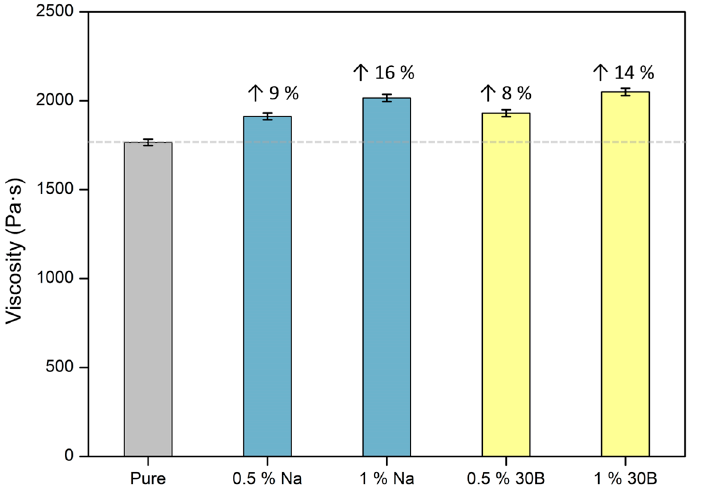
Figure 1. Viscosity values for the pure polyol blend and the polyol blend with the selected contents of both types of nanoclays.